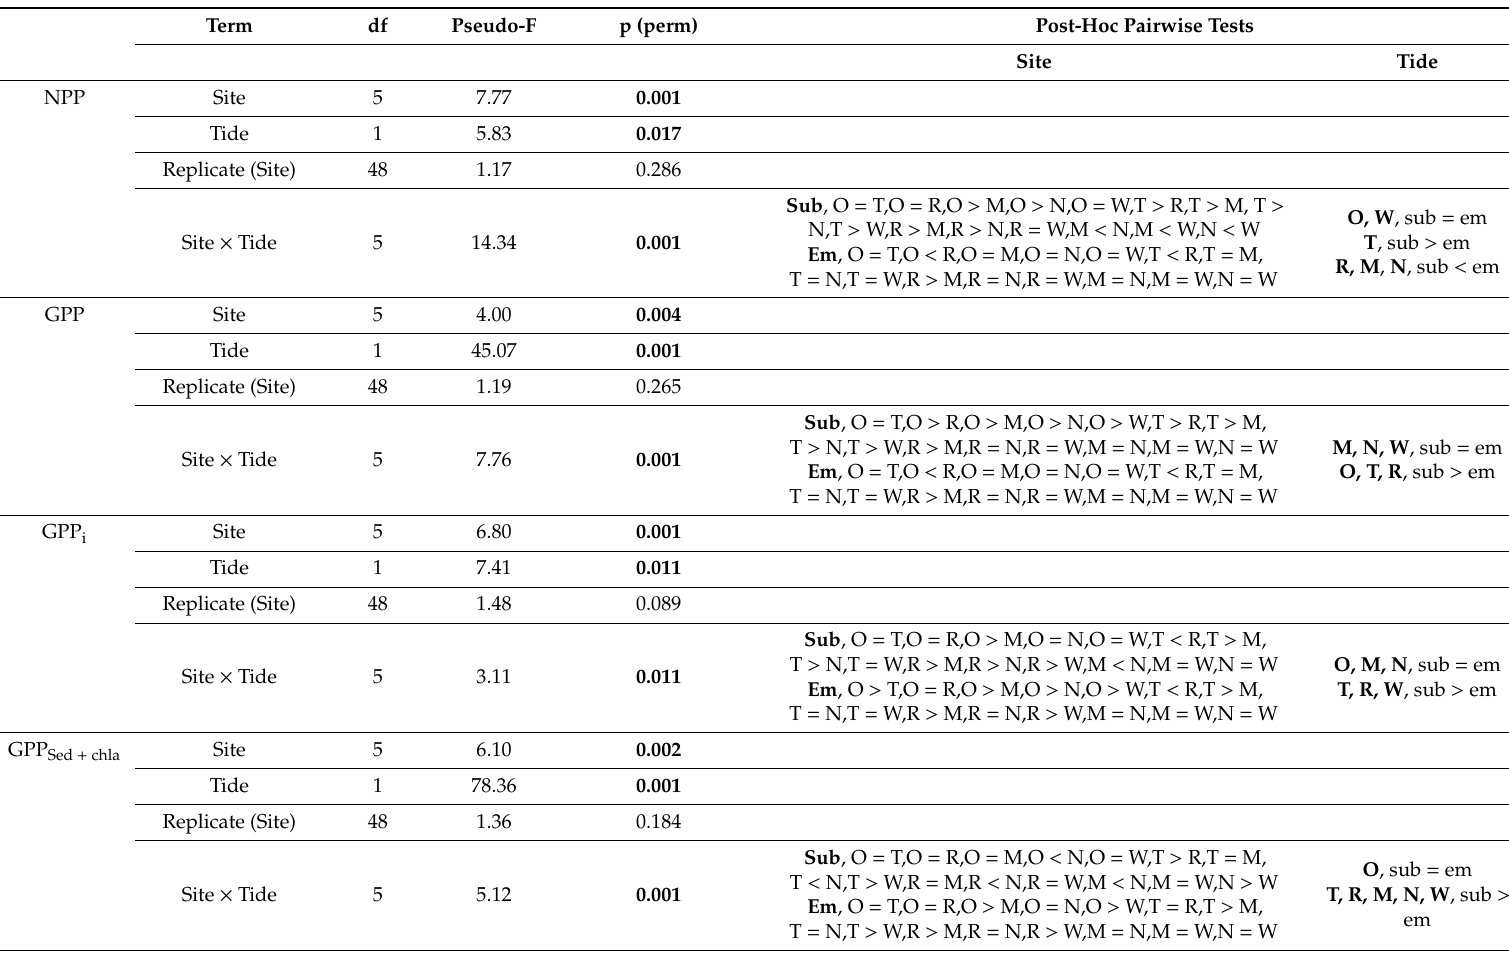
Table 4. Results of repeated measures PERMANOVAs testing the e ff ect of site and tidal state on measures of primary production made in November 2018 (T3). Site (6 levels) and tide (2 levels) were treated as fixed factors, and replicate plot nested within site. Site names have been further abbreviated to: M = MNK-L, N = MNK-R, R = RAG, O = TAU-O, T = TAU-T, W = WTA, and submerged and emerged tidal periods to sub and em, respectively. Significant e ff ects ( p < 0.05) are given in